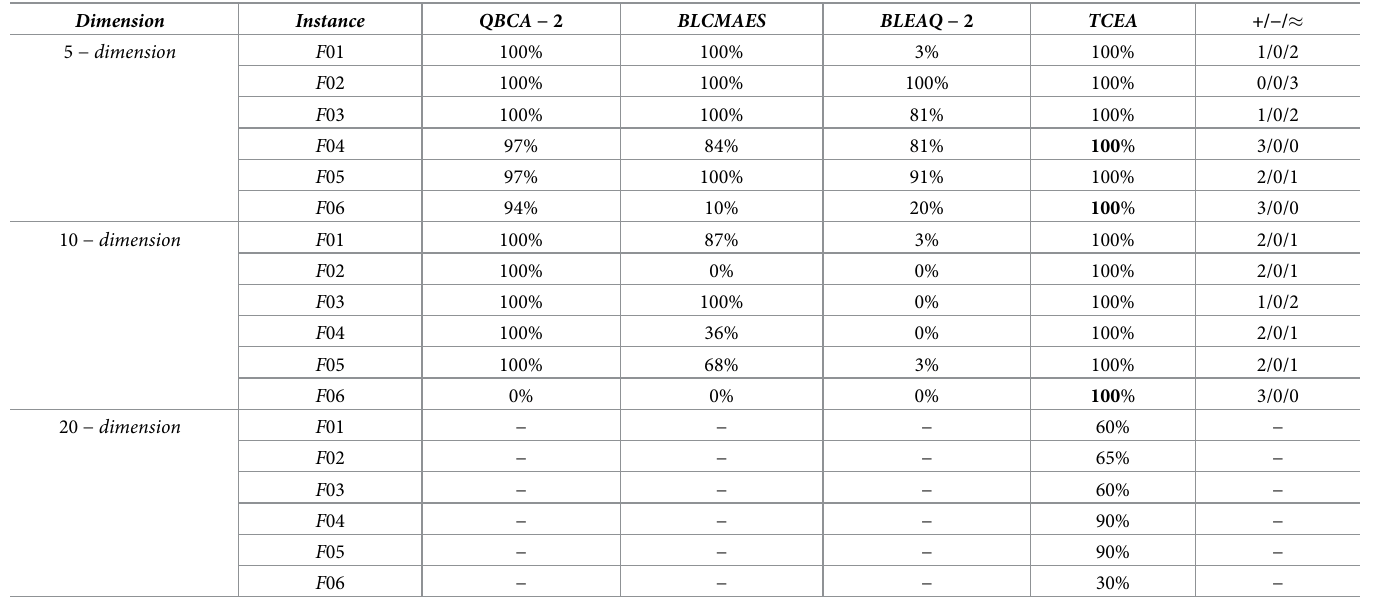
Table 4. Success rates of QBCA-2, BLCMAES, BLEAQ-2 and TCEA on 5, 10 and 20-dimensional test problems.